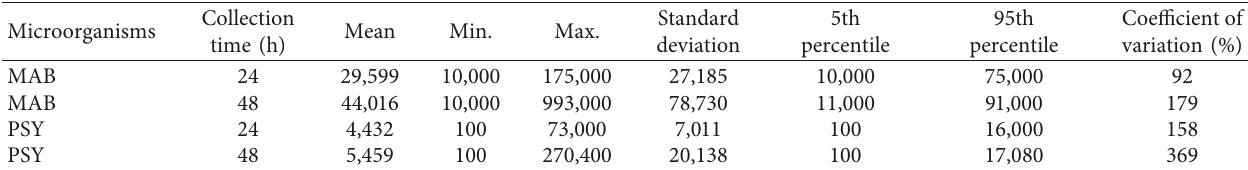
Table 1: Mesophilic aerobic bacteria (MAB, CFU/mL) and psychrotrophic bacteria (PSY, CFU/mL) counts obtained according to the frequency of milk collection (24 and